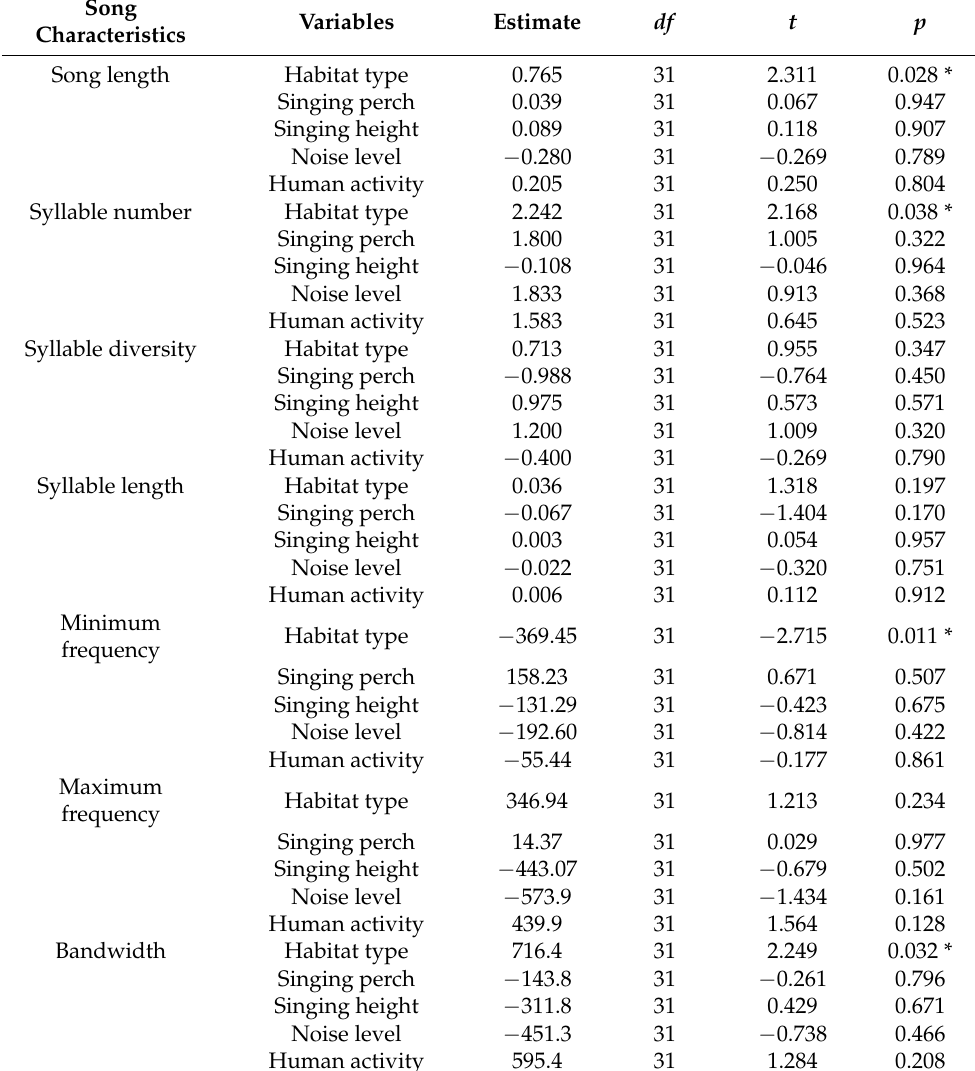
Table 2. Summary of linear mixed-effects models in testing the impacts of habitat type, singing perch, sing height, noise level, and human activity on song characteristics (* p <